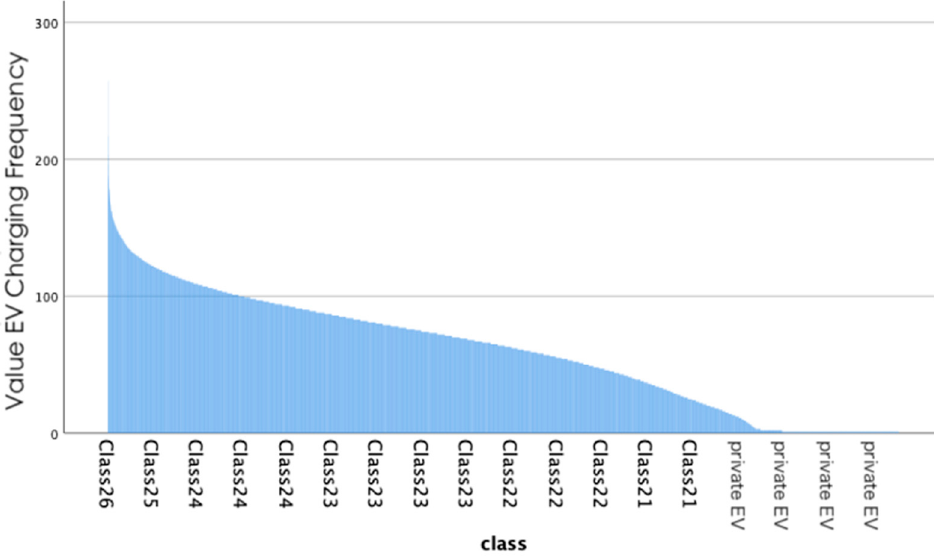
Figure 5. EV charging frequency area chart for different operating models .